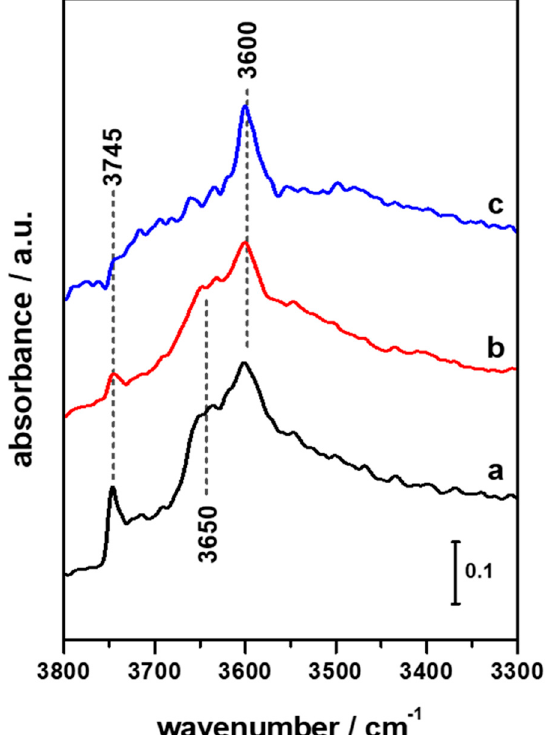
Figure 1. FTIR spectra of HFER8 (a, black curve), HFER30 (b, red curve) and HFER60 (c, blue curve) upon activation at 623K.